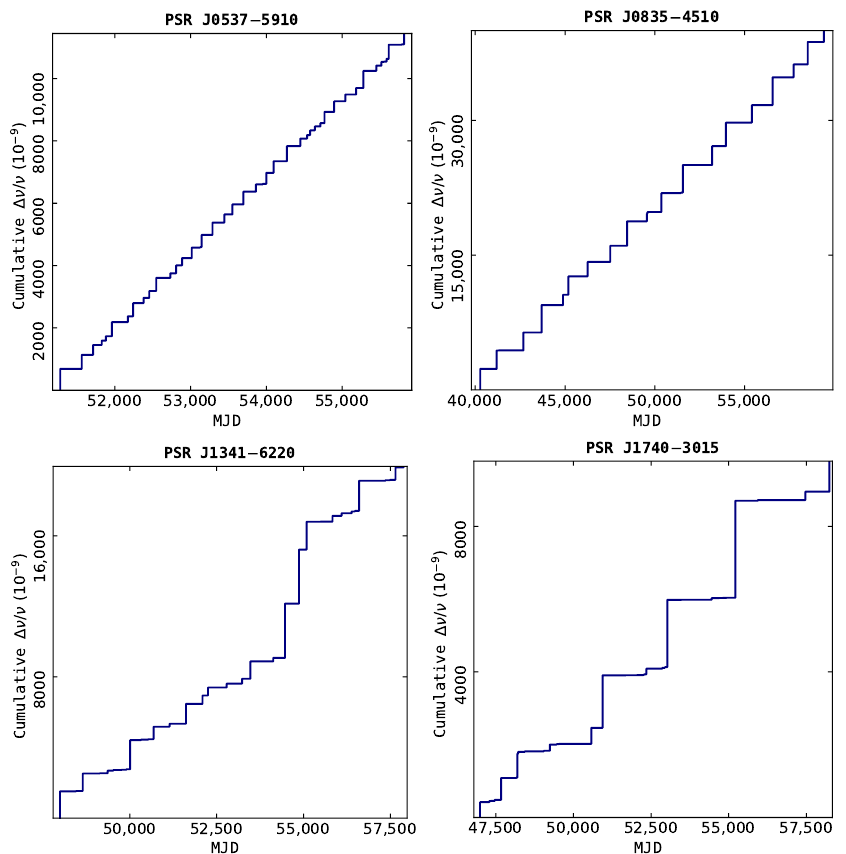
Figure 11. The accumulated ∆ ν / ν ( 10 − 9 ) for the most frequent glitching pulsars PSRs J0537 − 6910, J0835 − 4510 (Vela), J1341 − 6220 and J1740 −